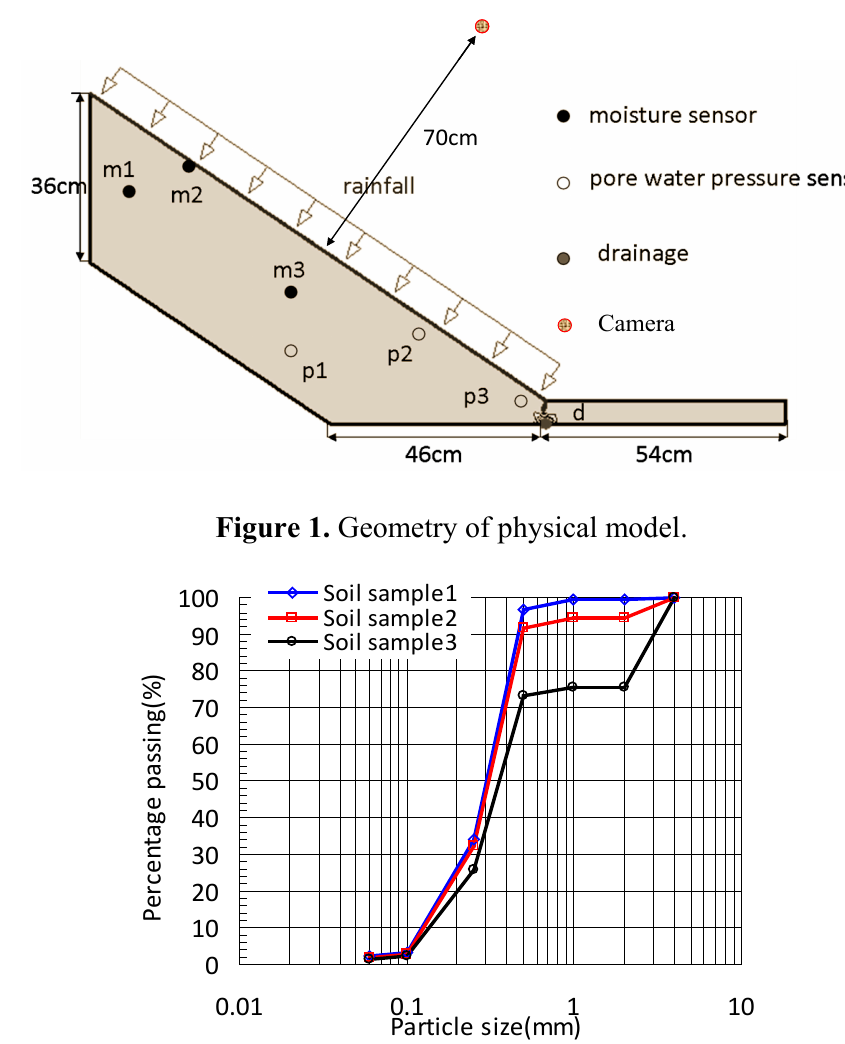
Figure 2. The soil sample was squeezed by a plate with a 120 N force to form the slope.